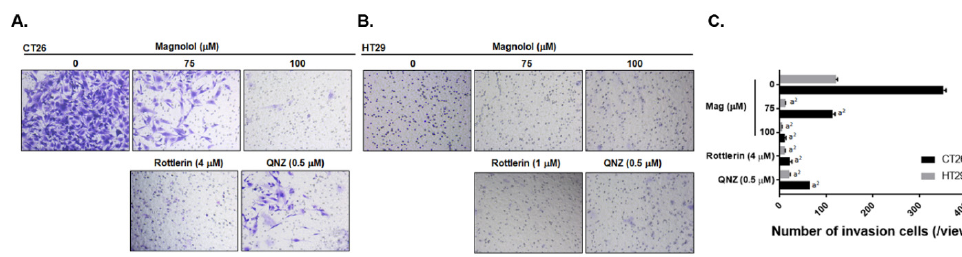
Figure 4. Tumor invasion capacity is suppressed by magnolol in CRC cells. One represented transwell invasion membrane from each group and average of repeated result in ( A,B ) CT26 and ( C ) HT29 is displayed. (a 2 p < 0.01 vs 0 μ M magnolol).